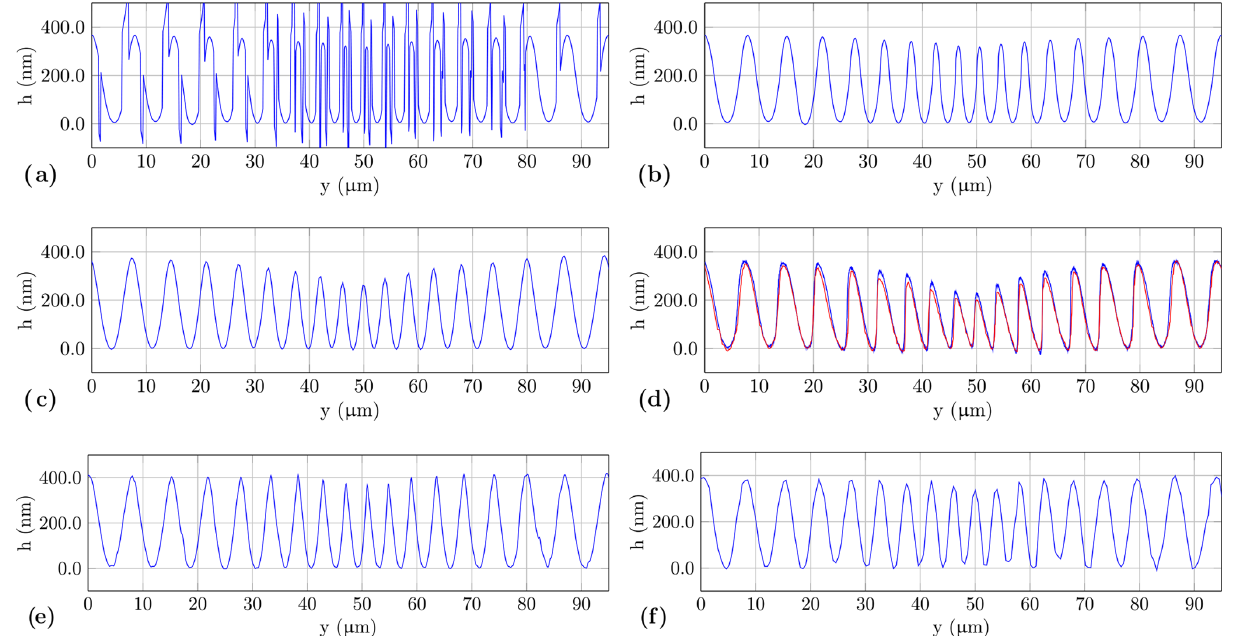
Figure 6. Profiles of the fine chirp structure obtained by various topography sensors: (a) 50 × Mirau interferometer with a A N of 0.55 (phase evaluation using the LT algorithm) and a central wavelength of 590nm, (b) unwrapped profile from (a) , (c) confocal microscope, (d) high- speed sensor with two different scan velocities (blue: 0.1mms − 1 ; red: 1mms − 1 ), (e) AFM with a Tap190Al-G cantilever and (f) contact stylus instrument with a scan velocity of 0.5mms − 1 by using a probe according to DIN EN ISO 3274 (2µm tip radius and an aperture angle of 60 ◦